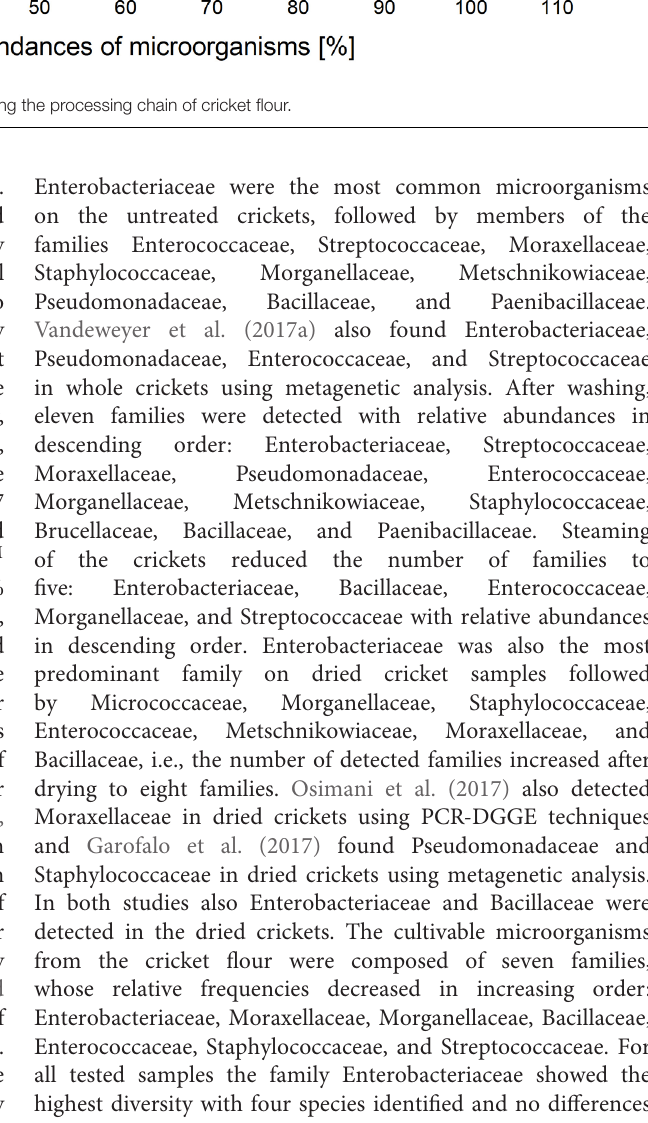
FIGURE 3 | Relative abundances of analyzed microorganisms from crickets along the processing chain of cricket flour.